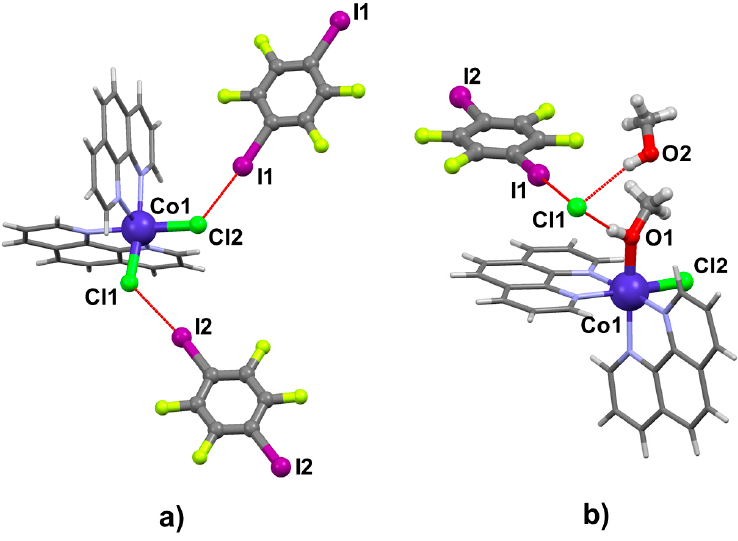
Figure 4. Structure of: ( a ) compound 1 ; and ( b ) compound 2 .